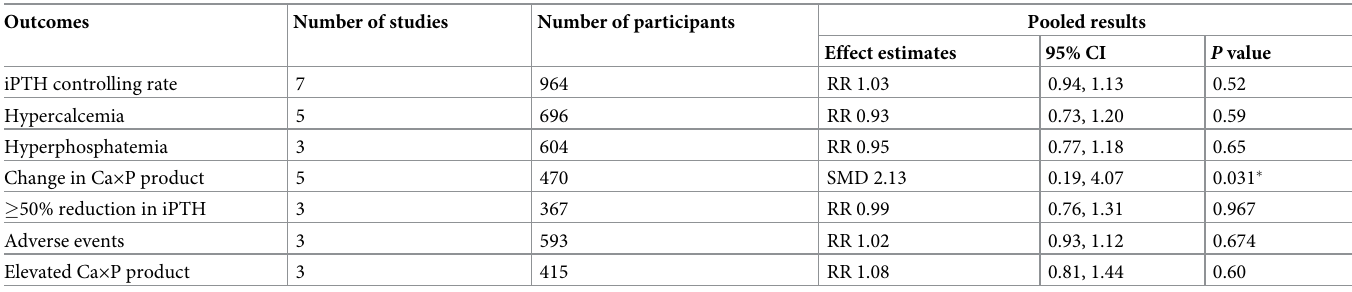
Table 2. The pooled results of other outcomes for the comparison of paricalcitol versus VDRA.